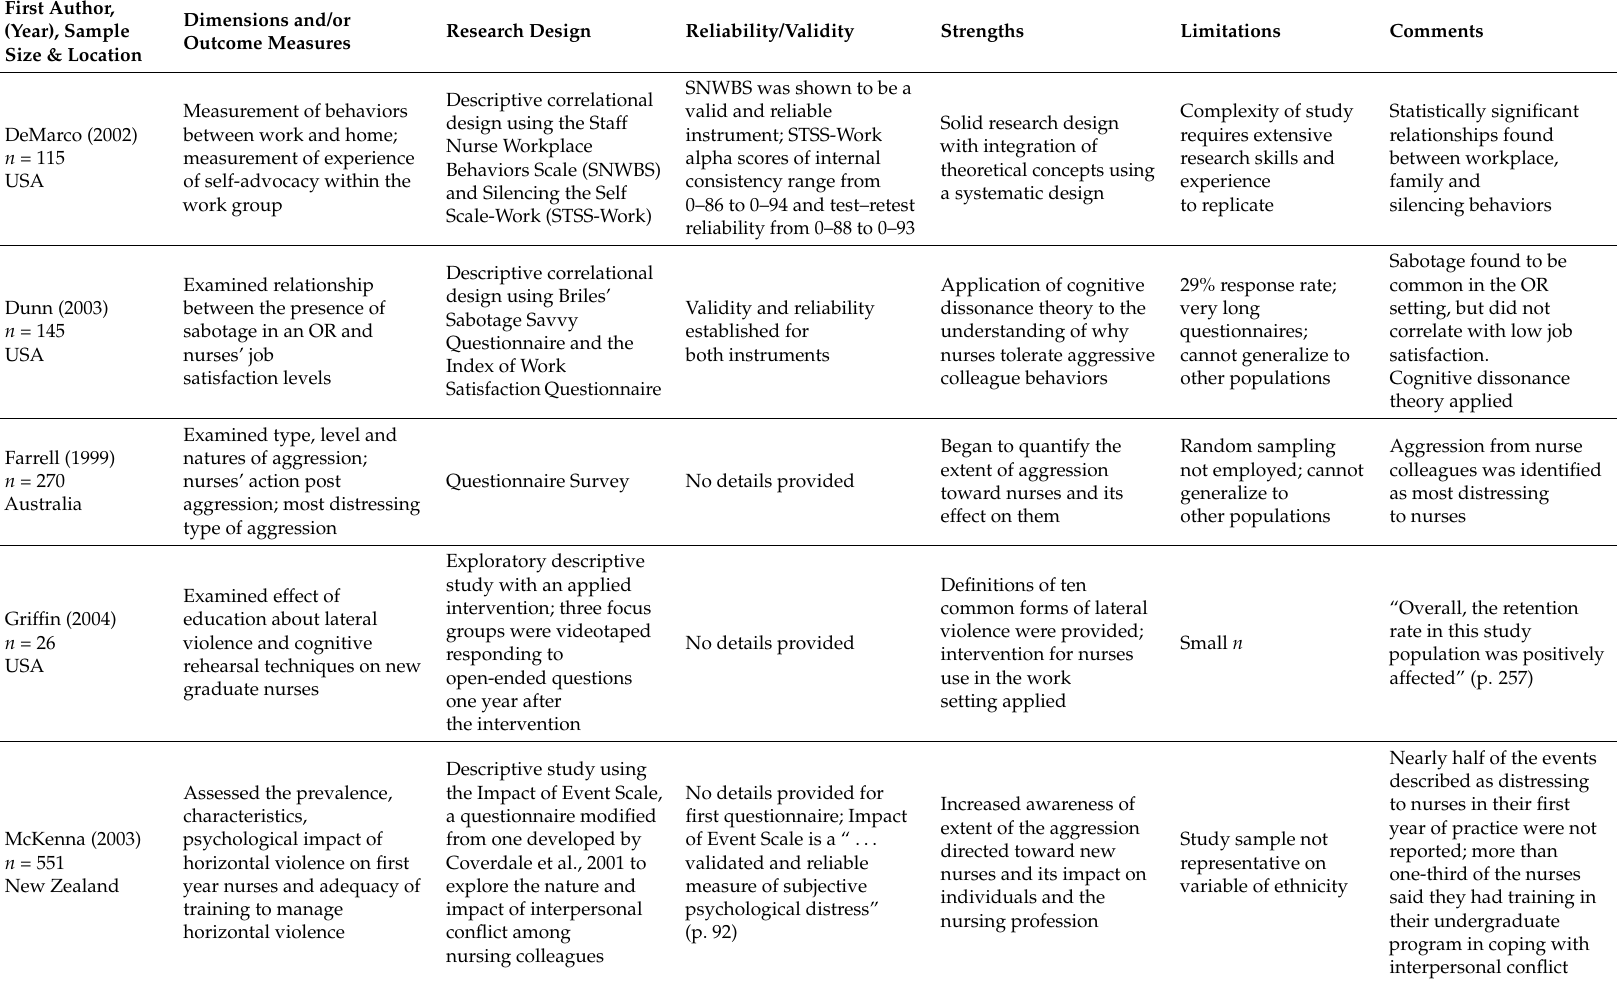
Table 1. Nursing research that influenced development of the Lateral Violence in Nursing (LVNS)